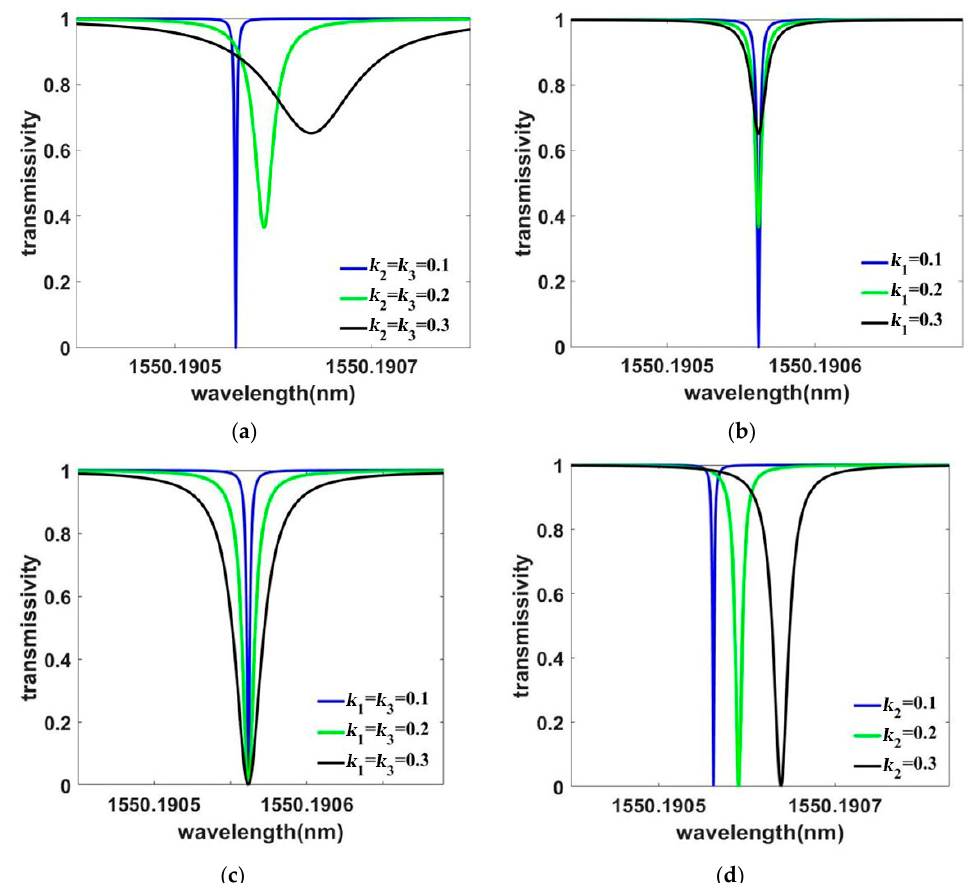
Figure 6. ( a ) The transmissivity of the double ring resonator at different wavelengths and coupling coefficients ( k 2 , k 3 ); ( b ) the transmissivity of the double ring resonator at different wavelengths and coupling coefficients ( k 1 ); ( c ) the transmissivity of the double ring resonator at different wavelengths and coupling coefficients ( k 1 , k 3 ) and ( d ) the transmissivity of the double ring resonator at different wavelengths and coupling coefficients ( k 2 ). All other unchanged coupling coefficients are fixed at 0.1.